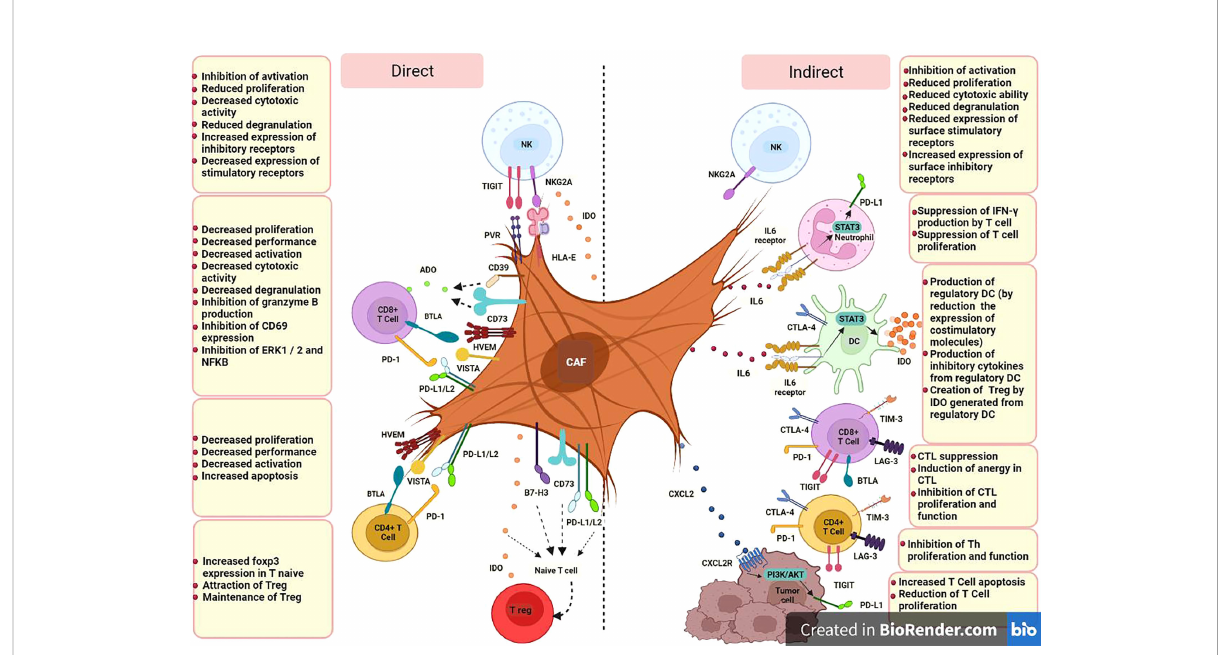
FIGURE 1 CAF cells could modulate immune cell function in TME through iICPs in two ways; direct expression of inhibitory membrane-associated molecules and indirect induction of them by producing soluble factors. CD8+ T cell, Cytotoxic T-cell (CTL);CD4+ T cell, Helper T-cell (Th); DC, Dendritic Cell; NK, Natural killer cell; T reg, Regulatory T cell; PD-L1, Programmed Cell Death Ligand 1; PD-L2, Programmed cell death-ligand 2; IDO, Indoleamine 2;3 dioxygenase; ADO, Adenosine; HLA-E, human leukocyte antigen E; PVR, poliovirus receptor; A2B, adenosine A2B receptor; NKG2A, CD159a; TIM-3, T-cell immunoglobulin and mucin-domain containing-3; PD-1, programmed cell death; CTLA-4, cytotoxic T- lymphocyte-associated antigen-4; LAG-3, lymphocyte-activation gene- 3; BTLA, B and T lymphocyte attenuator; TIGIT, T cell immunoglobulin and ITIM domain; HVEM, herpes virus entry mediator; VISTA, V-domain immunoglobulin suppressor of T cell activation; B7-H3, CD276; CD, Cluster of Differentiation; IL, Interleukin; CXCL, C-X-C Motif Chemokine Ligand; CXCR, C-X-C chemokine receptor; STAT3, Signal transducer and activator of transcription 3; IFN- g ,